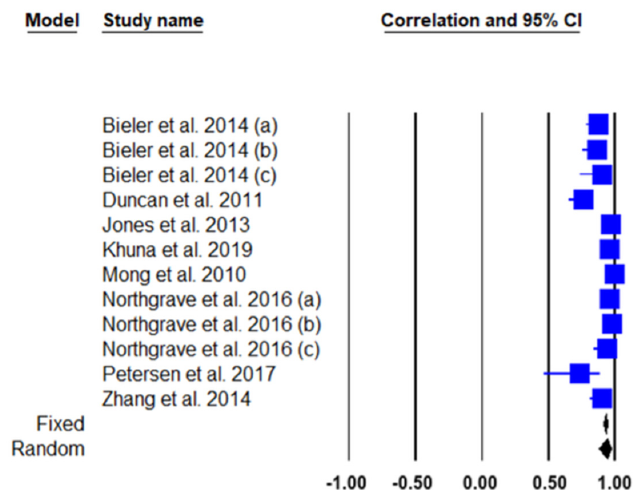
Figure 2. Reliability forest plot between test-retest for every study (fixed and random effects mod-